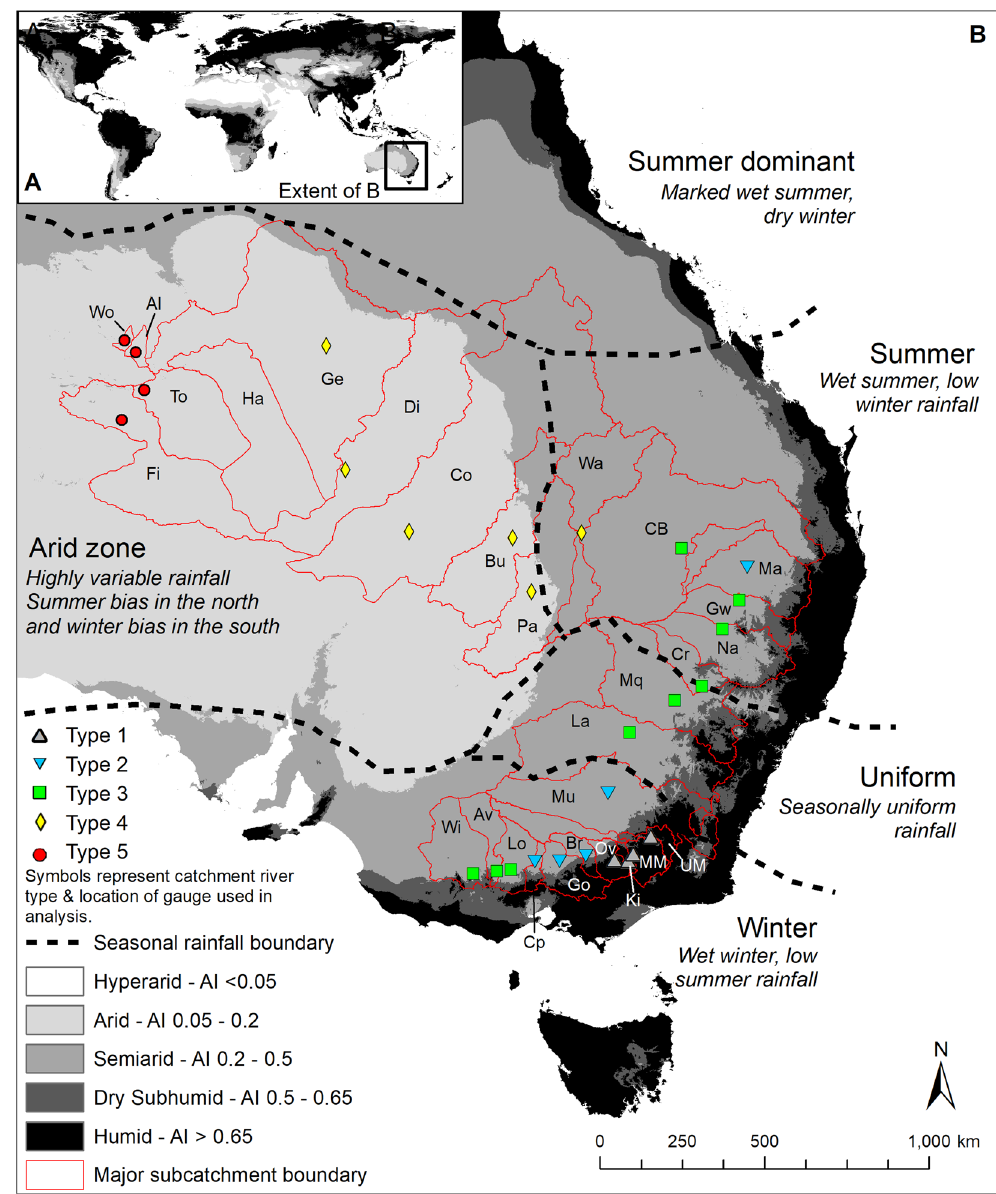
Figure 2. Modern, global Aridity Index [AI] (defined as mean annual precipitation [PPT]/annual potential evapotranspiration [PET]) for ( A ) the world and ( B ) central and eastern Australia. AI data were sourced from a publicly available dataset 57 . Drylands have AI < 0.65 56 . Currently, there are no hyperarid regions on the Australian continent. In B), seasonal rainfall boundaries are marked by dashed black lines and are adapted from the Australian Bureau of Meteorology’s climate classification data. Stream gauges were selected nearest to the end of bedrock confinement in each catchment and symbols represent different river types (see Fig. 1). Study catchments are labelled as follows: Ki – Kiewa, MM – Mitta Mitta, Ov – Ovens and UM – Upper Murray